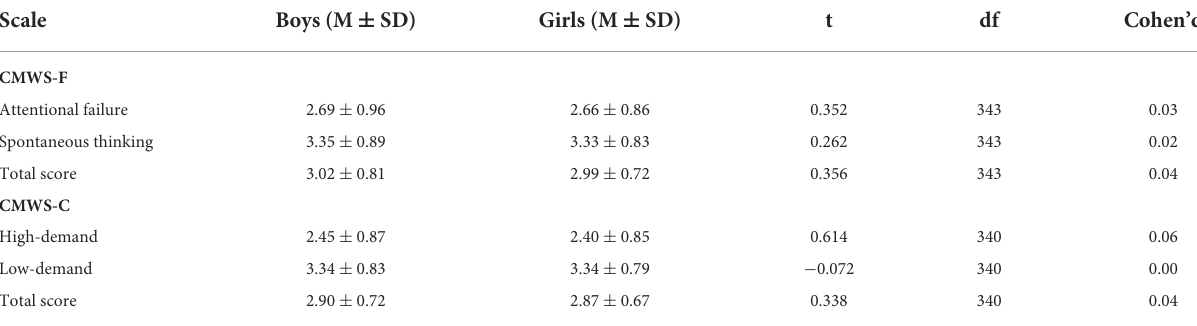
TABLE 2 Gender comparisons for CMWS-F/CMWS-C scores in study